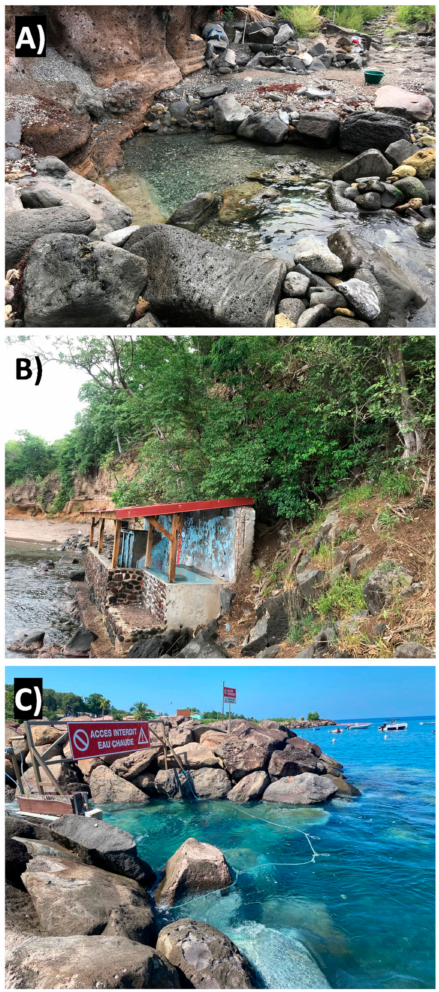
Figure 8. Images of selected hot springs and hot water effluents in the Bouillante sector. ( A ) Anse Thomas; ( B ) Bain du Cur é ; ( C ) Hot water discharge at sea from the geothermal power plant ( source chaude du bourg ; courtesy of B. Hira, ORMAT